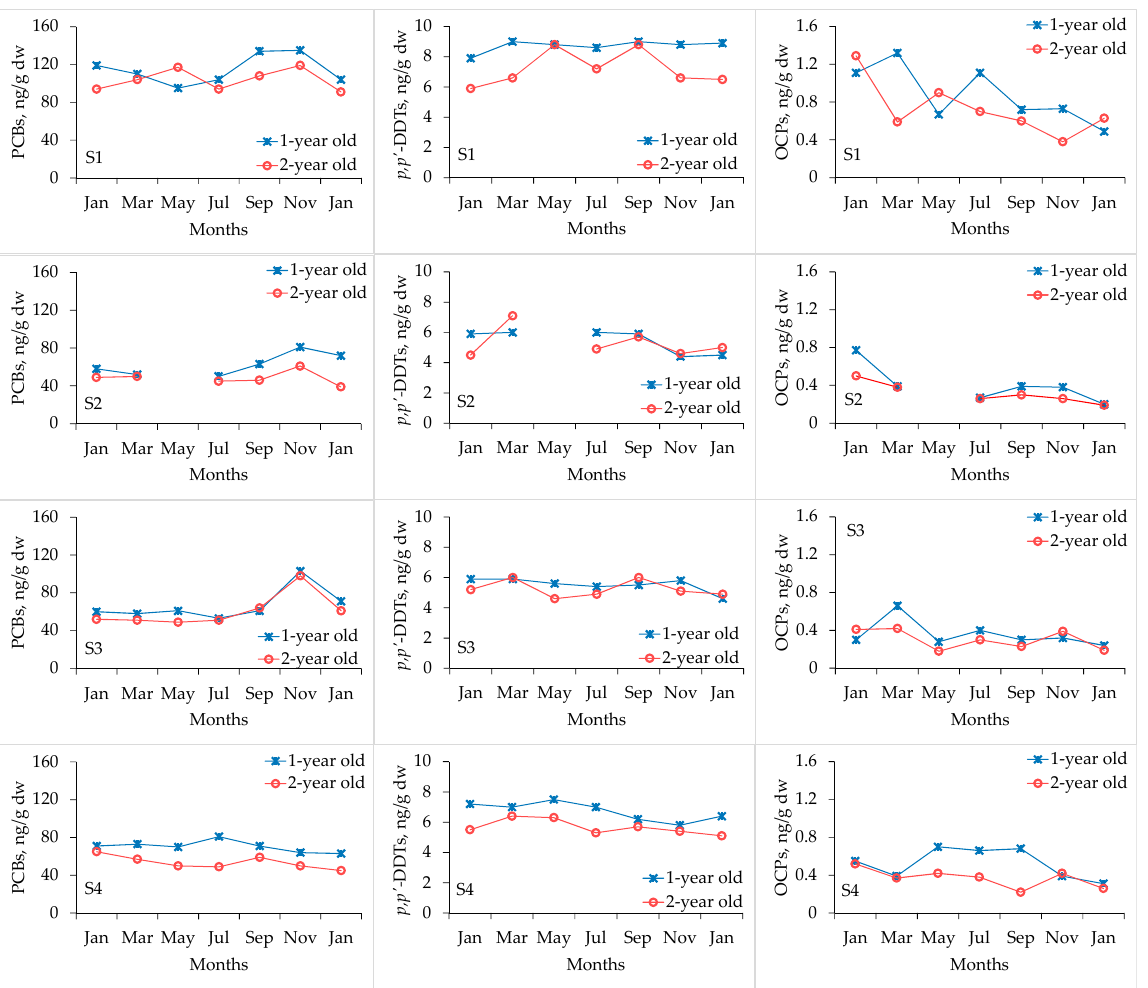
Figure 4. Variation of organochlorine pesticides (OCPs), p,p’ -dichlorodiphenyltrichloroethane ( p,p ′ -DDTs ( Σ DDE, DDD, and DDT)), and polychlorinated biphenyls (PCBs) during bimonthly exposure of transplanted mussels to Kaštela Bay as spatial and temporal accumulation. Mussels set at S2 were not found in May.